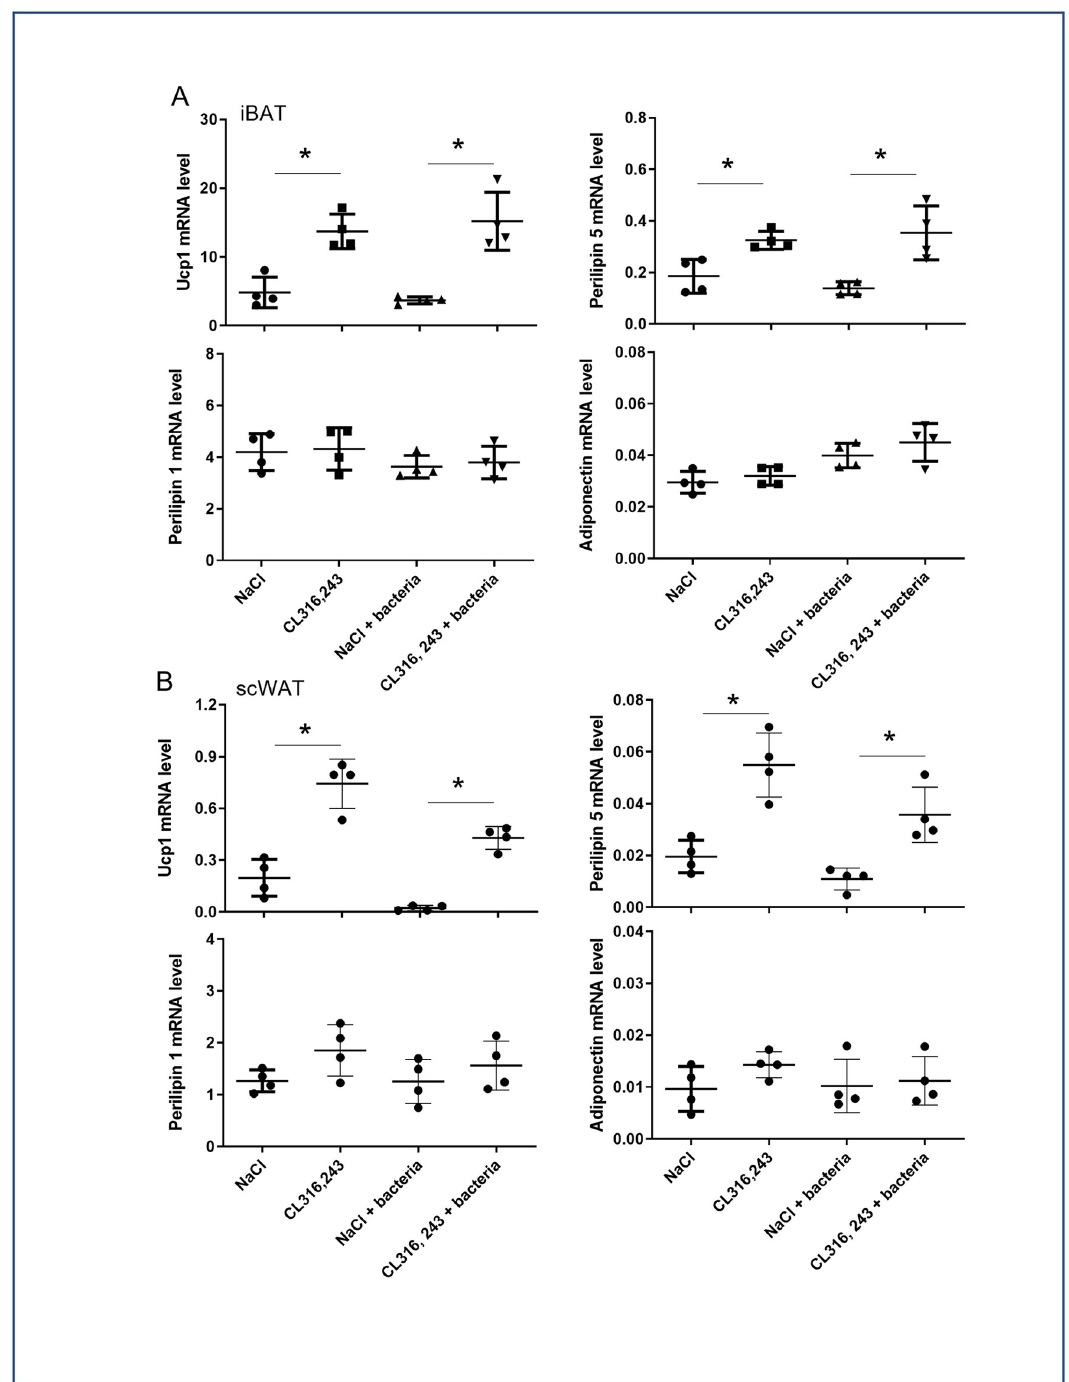
Fig 2. Effect of CL316,243 and bacteria on mRNA of adipocyte markers. mRNA expression of brown/brite (Ucp1 and perilipin 5) and general adipocyte (perilipin 1 and Adiponectin) markers was analysed by qPCR in iBAT and scWAT from mice that were treated for 1 week with CL316,243 daily (1 mg/kg/day) or vehicle only (NaCl), and then infected or not with E . coli for 48 hours. The results are displayed as independent values (dots) and the mean ± SD. n = 4. � p < 0.05.